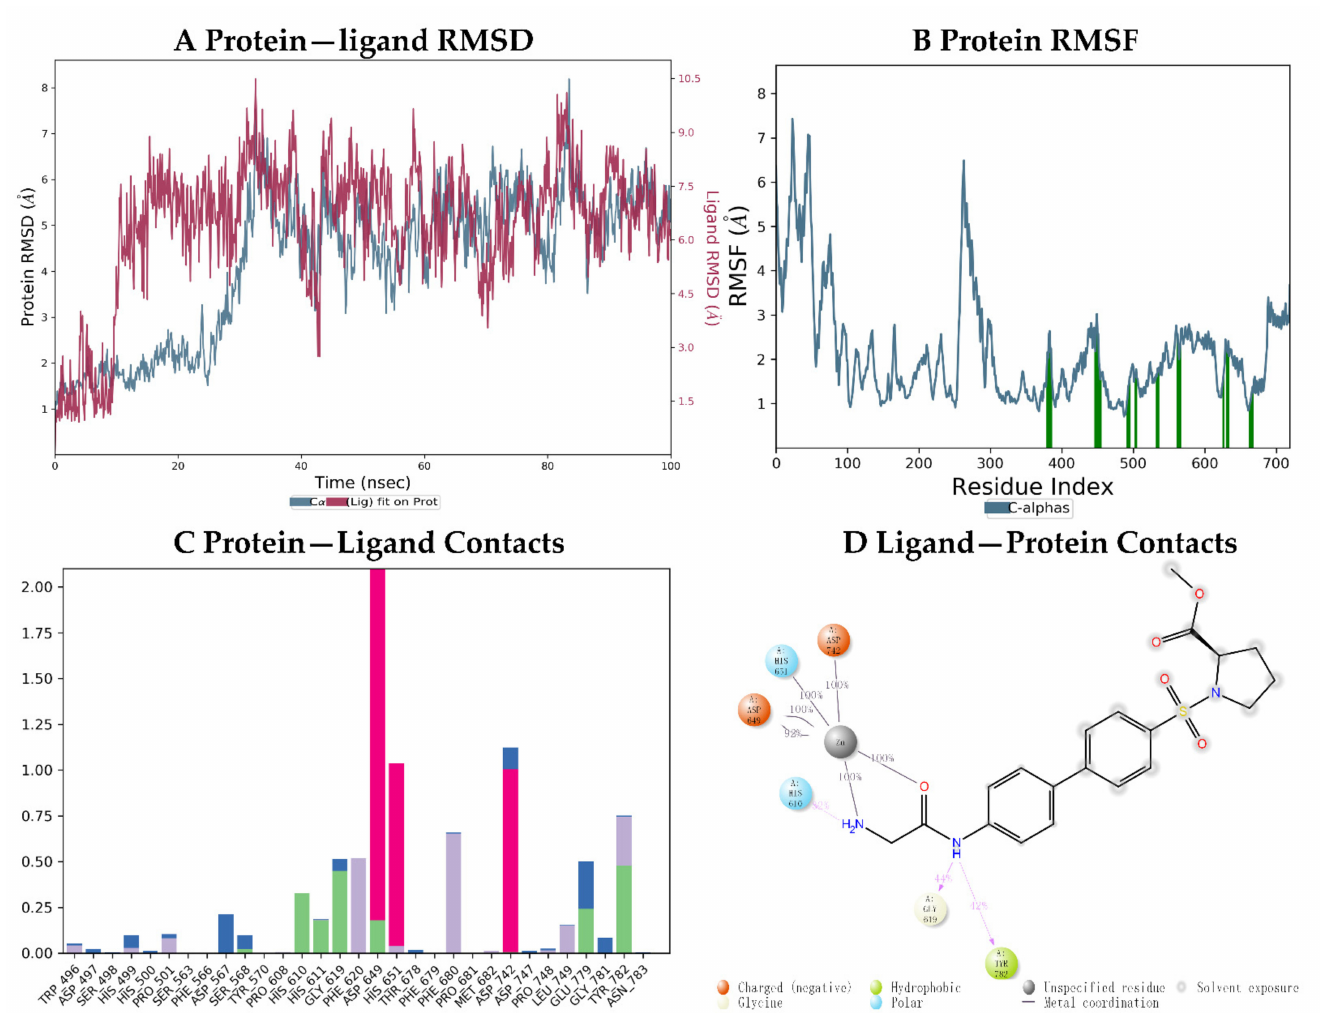
Figure 9. ( A ): Plot presenting the stability of protein–ligand interaction (RMSD). ( B ): The protein confor- mation changes along its side chain is represented in the RMSF throughout the trajectory. ( C , D ) represent the bar graph and the 2D interaction between the ligand and the protein throughout